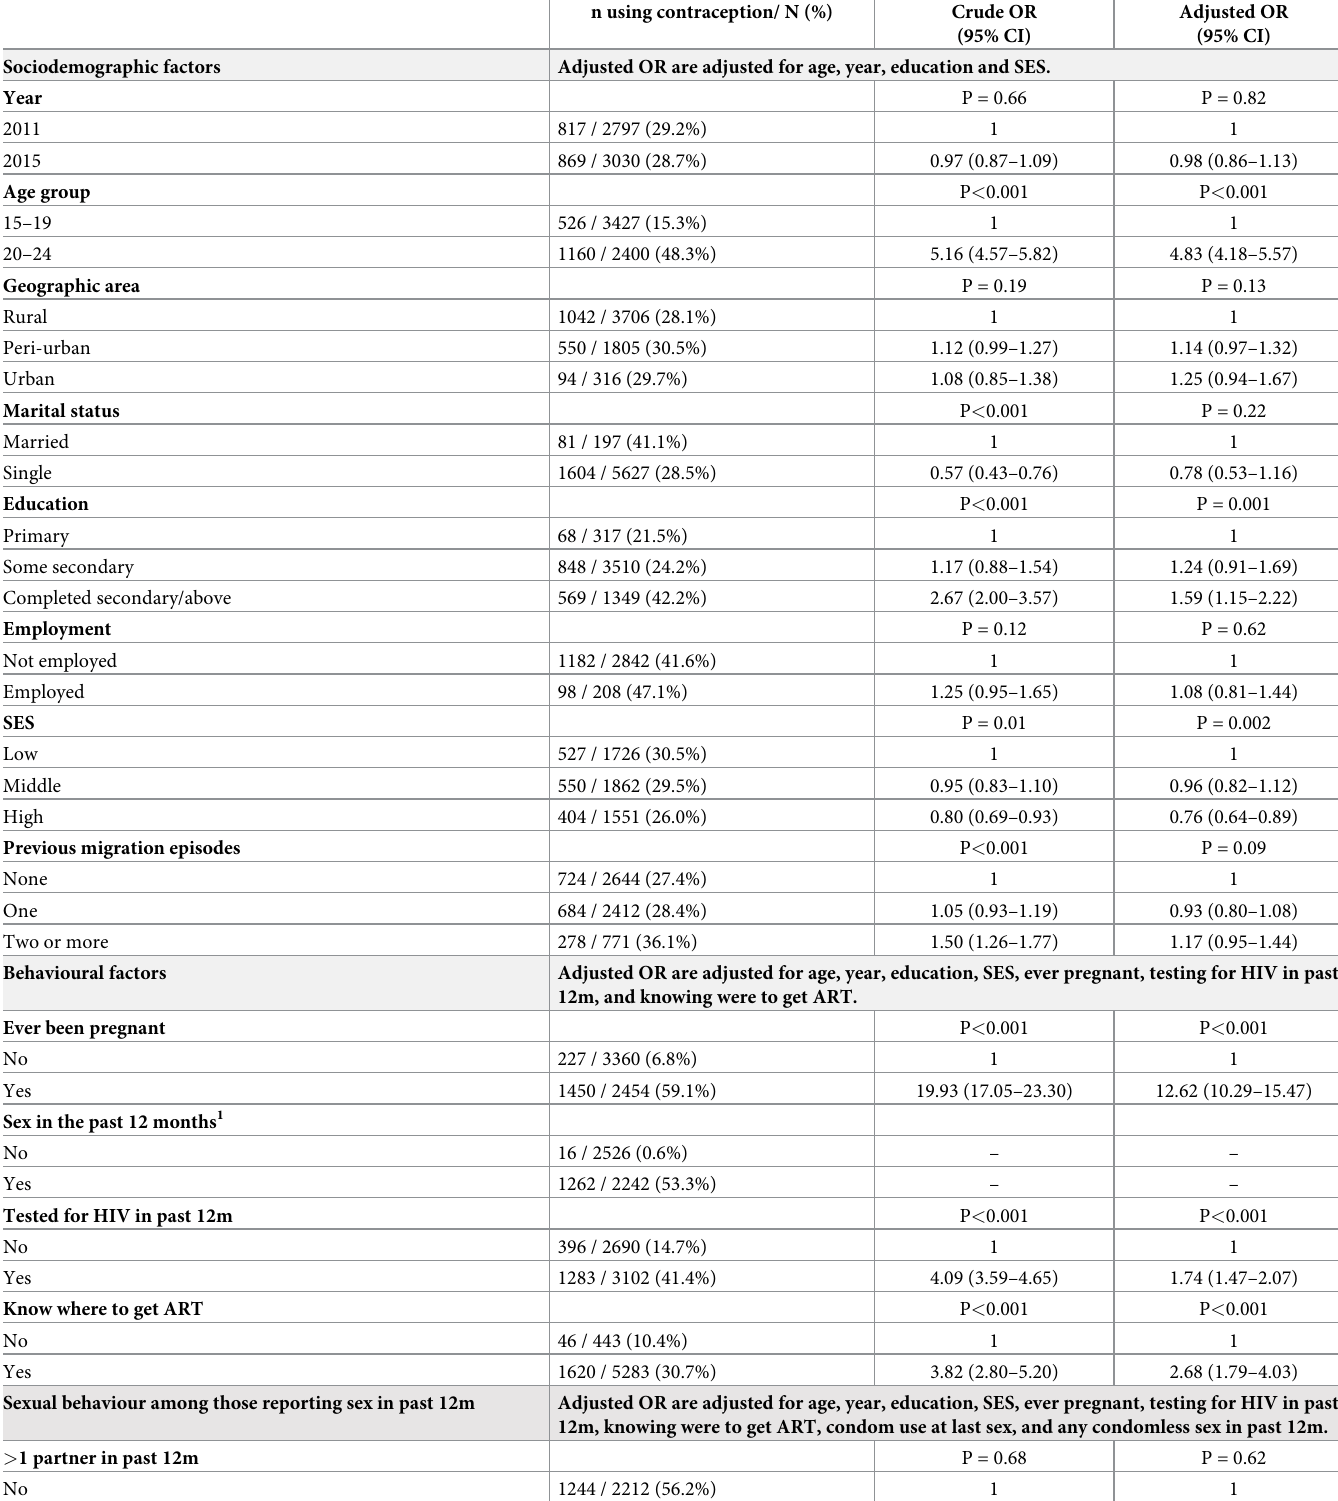
Table 4. Factors associated with current use of modern